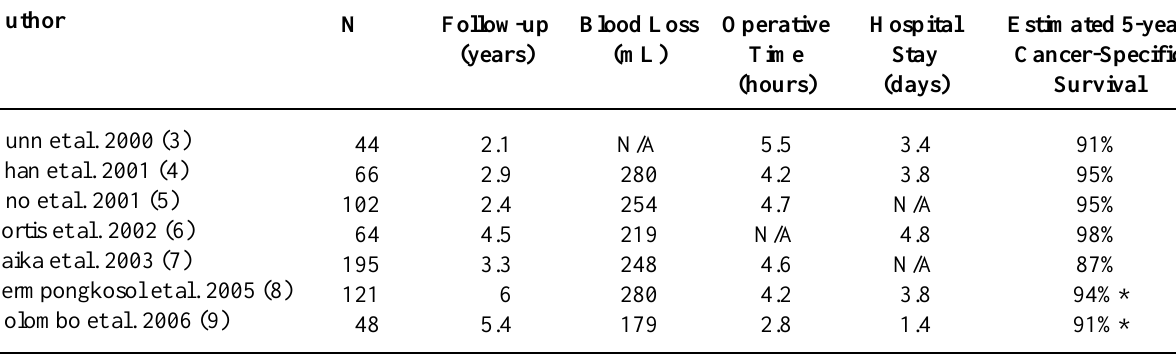
Table 1 – Laparoscopic radical nephrectomy oncological